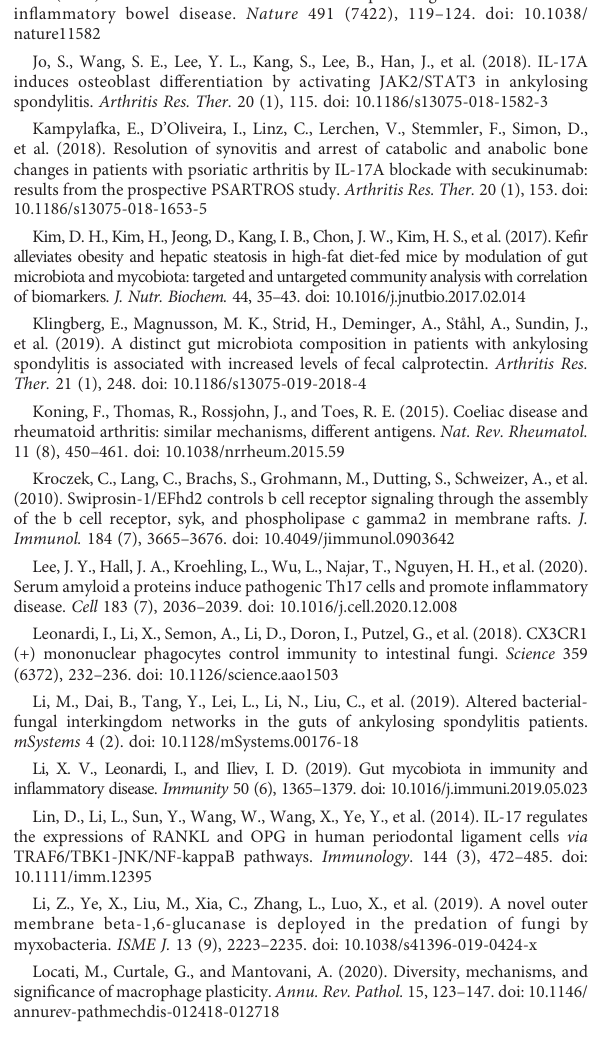
and FDR<0.05, A); KEGG analysis of differentially up-expressed 1016 genes (B) ; KEGG analysis of differentially down-expressed 1606 genes. SUPPLEMENTARY FIGURE S8 The GO classi fi cation of differentially expressed genes of RAW264.7 co- cultured with K.